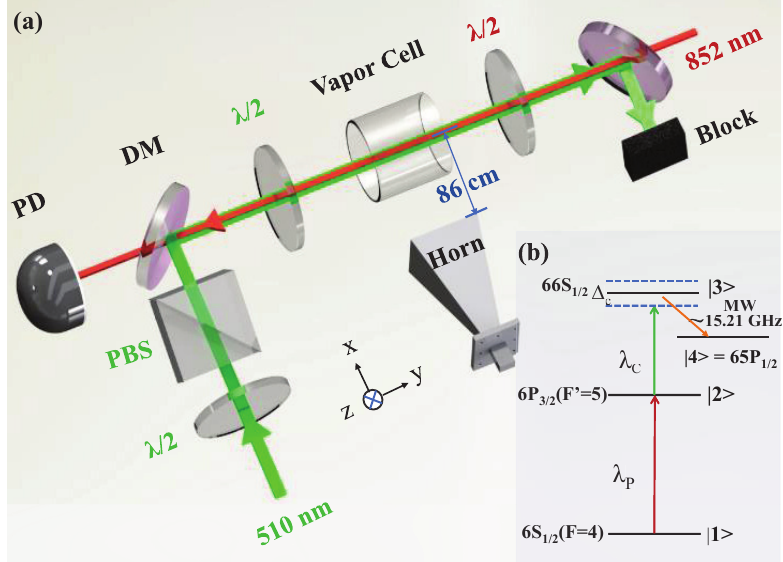
Figure 1. (color online) ( a ) Sketch of an experimental setup. The coupling, λ c = 510 nm, and probe, λ p = 852 nm, lasers counter-propagate through a cesium room-temperature vapor cell along the y -axis. The horn antenna, placed 86 cm far from the cell (not scaled), emits the microwave electric field with the frequency ∼ 15.21 GHz coupling Rydberg transition, producing an EIT-AT spectrum. The polarization of the microwave field is set to parallel to the polarization of probe and coupling beams. The probe beam is passed through a dichroic mirror (DM) and is detected with a photodiode detector (PD). PBS: polarized beam splitter; ( b ) Energy level diagram of cesium cascade four-level system. The probe laser is resonant with the lower transition, | 6 S 1/2 F = 4 (cid:105) → | 6 P 3/2 F (cid:48) = 5 (cid:105) , and the coupling laser is scanned through the Rydberg transitions, | 6 P 3/2 F (cid:48) = 5 (cid:105) → | 66 S 1/2 (cid:105) . ∆ c is the coupling laser detuning. The applied microwave electric field couples the transition, | 66 S 1/2 (cid:105) → | 65 P 1/2 (cid:105) , that forms Rydberg EIT-AT